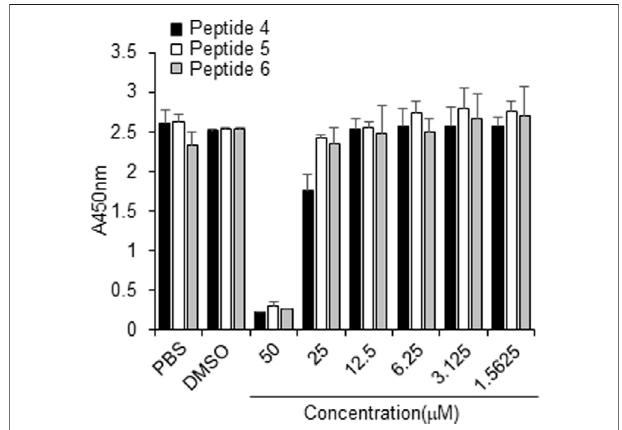
FIGURE 6 | Effect of peptides 4, 5, and 6 on the proliferation of Vero cells. Peptides (100 µM) weredissolved in10%DMSO, and then thepeptides were two-fold serially diluted in PBS. Vero cells were treated with PBS, 1% DMSO, or indicated peptide concentrations for 3 days, followed by the CCK-8